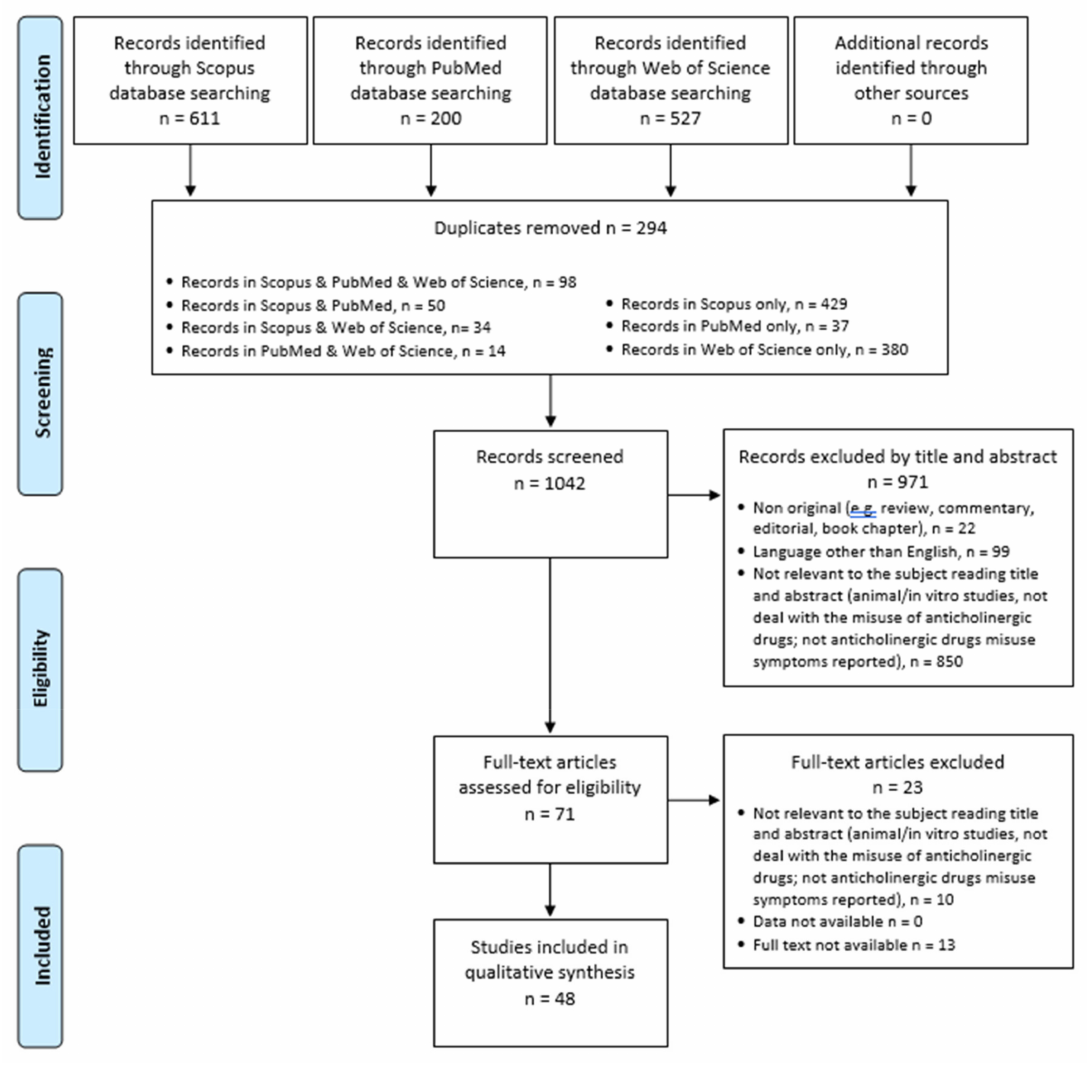
Figure 1. PRISMA flow